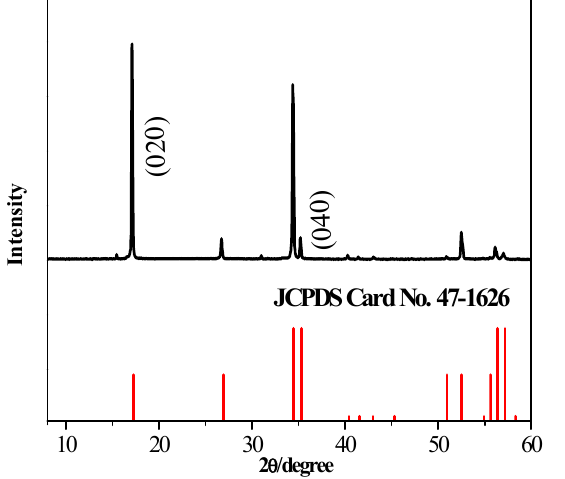
Figure 3. Raman spectra of BP, PN, and PN-TiO 2 .